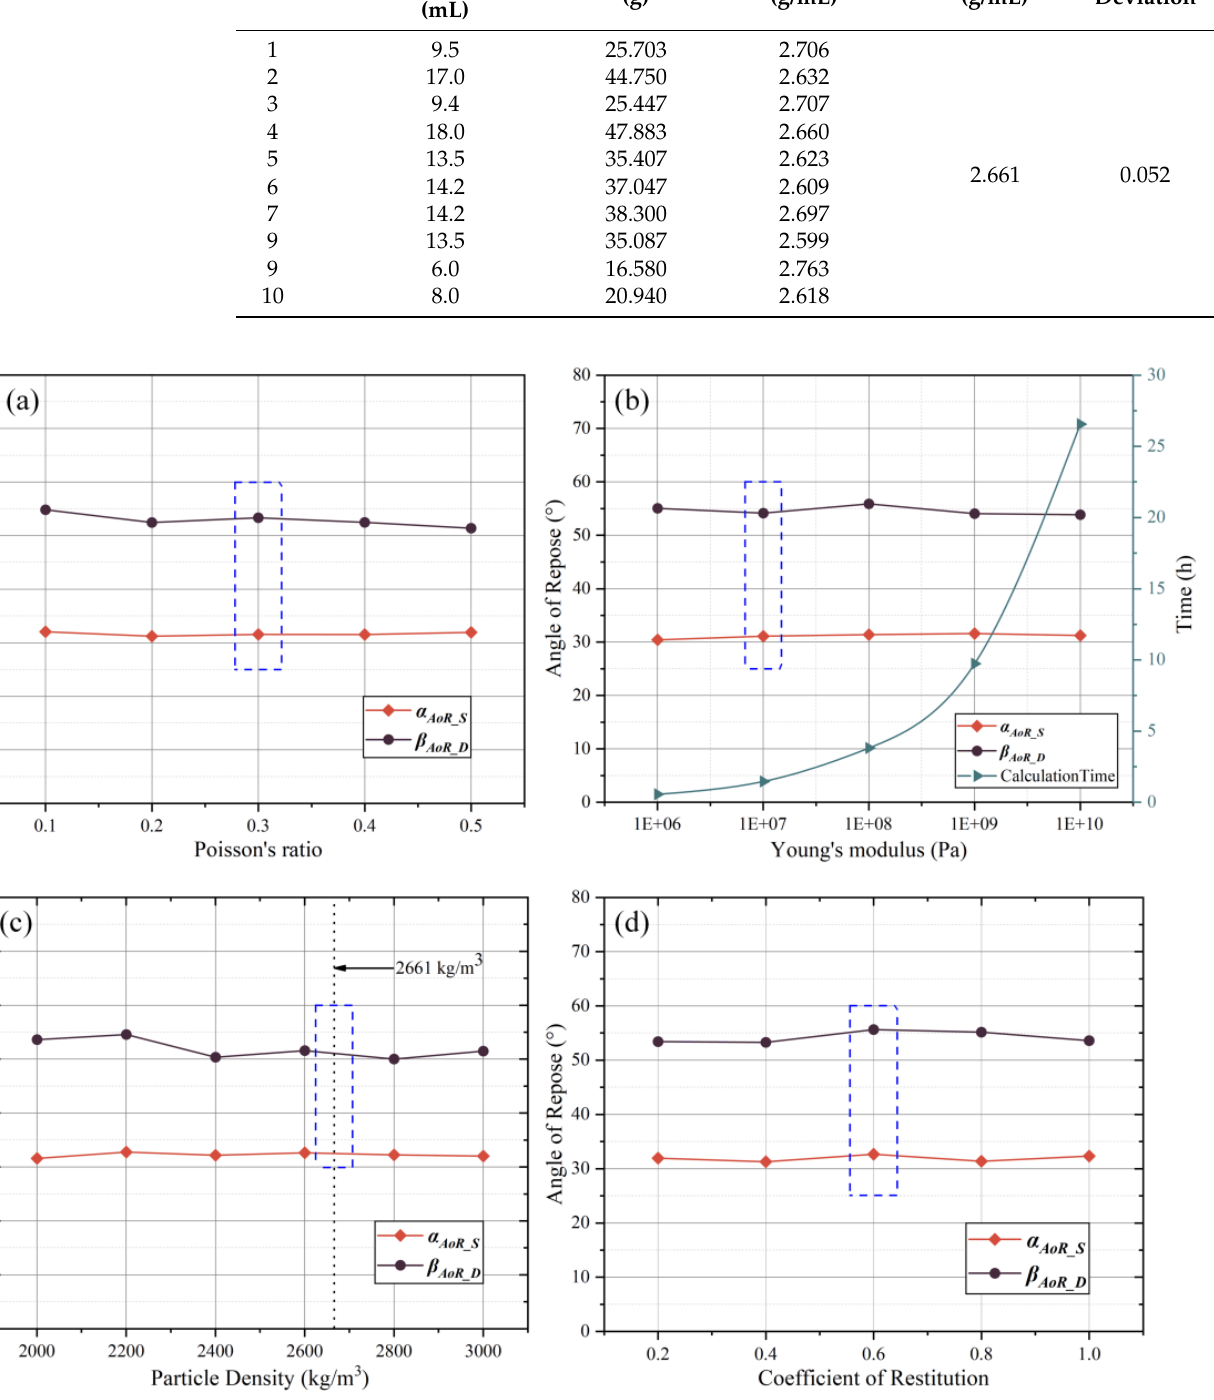
Figure 8. Particle intrinsic parameters: ( a ) Poisson’s ratio; ( b ) Young’s modulus; ( c ) particle density; ( d ) coefficient of restitution.